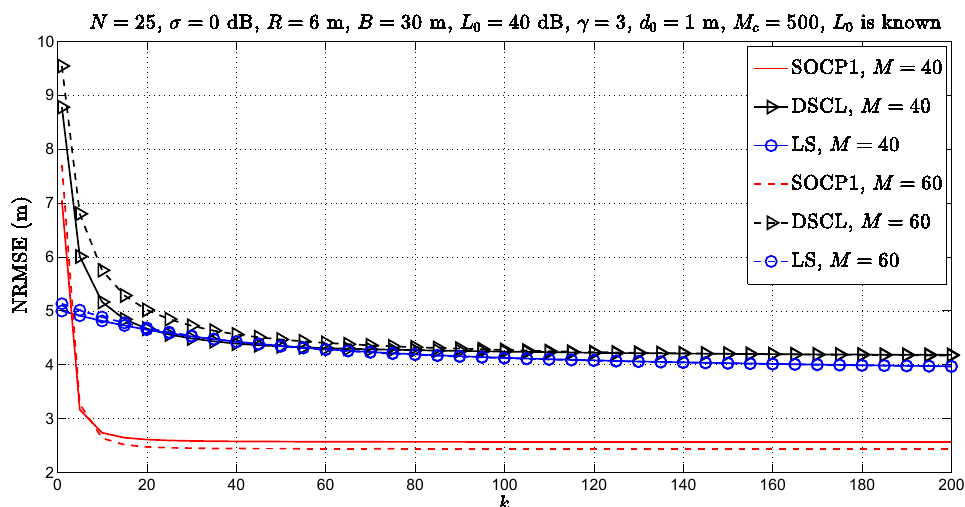
is known: NRMSE versus 0 = 40 dB, 0